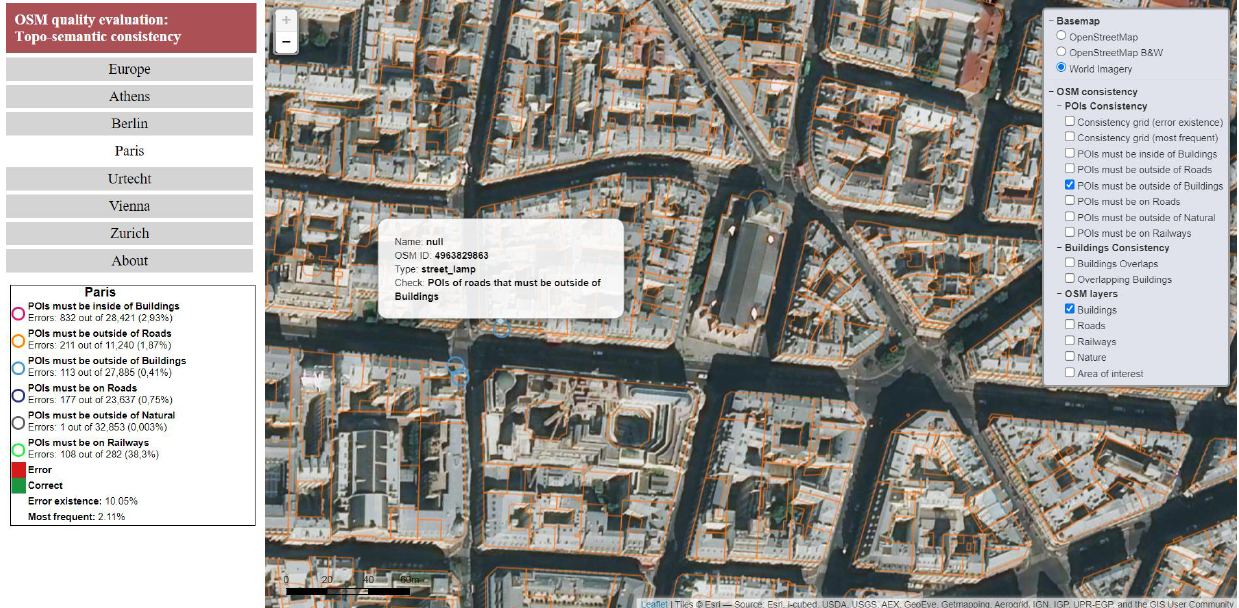
Figure A9. Errors from the topo-semantic consistency check “POIs must be outside of Buildings” for Paris are portrayed on the World Imagery basemap. The “Buildings” layer is portrayed as well. Additional information is provided by clicking on each error.